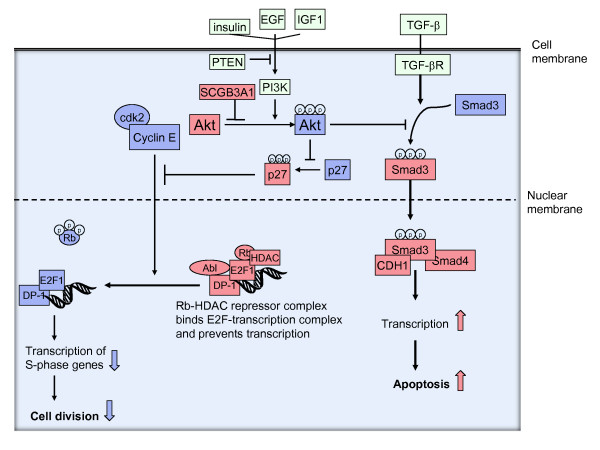
Simplified illustration of the cellular mechanisms of action of SCGB3A1. SCGB3A1 inhibits the phosphorylation of Akt leading to reduced cell cycle division and increased apoptosis. Molecules in red are increased/stimulated as result of SCGB3A1-action, whereas molecules in blue are decreased/inhibited.